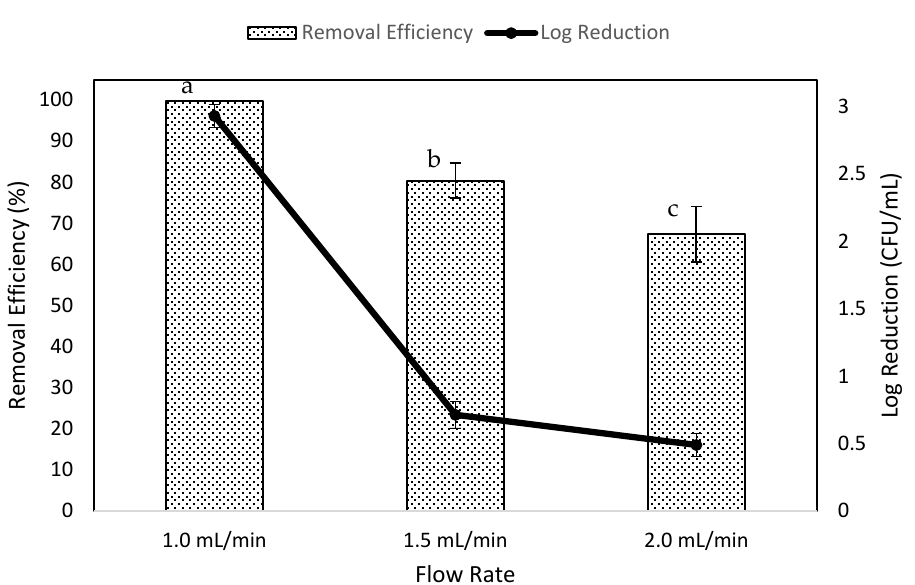
Figure 8. The effects of three different flow rates on removal efficiency over a 120 min period (bead size = 200 µm, voltage = 60 V).